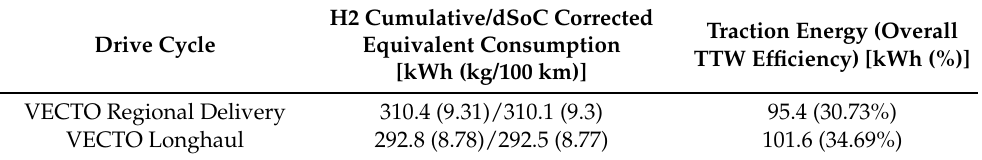
Table 3. Overall simulation results for the HD 40-tonne fuel cell truck: Cumulative fuel energy consumption, SoC corrected fuel energy consumption, traction energy expenditure and overall tank-to-wheel (TTW) efficiency for VECTO Regional delivery and Longhaul drive